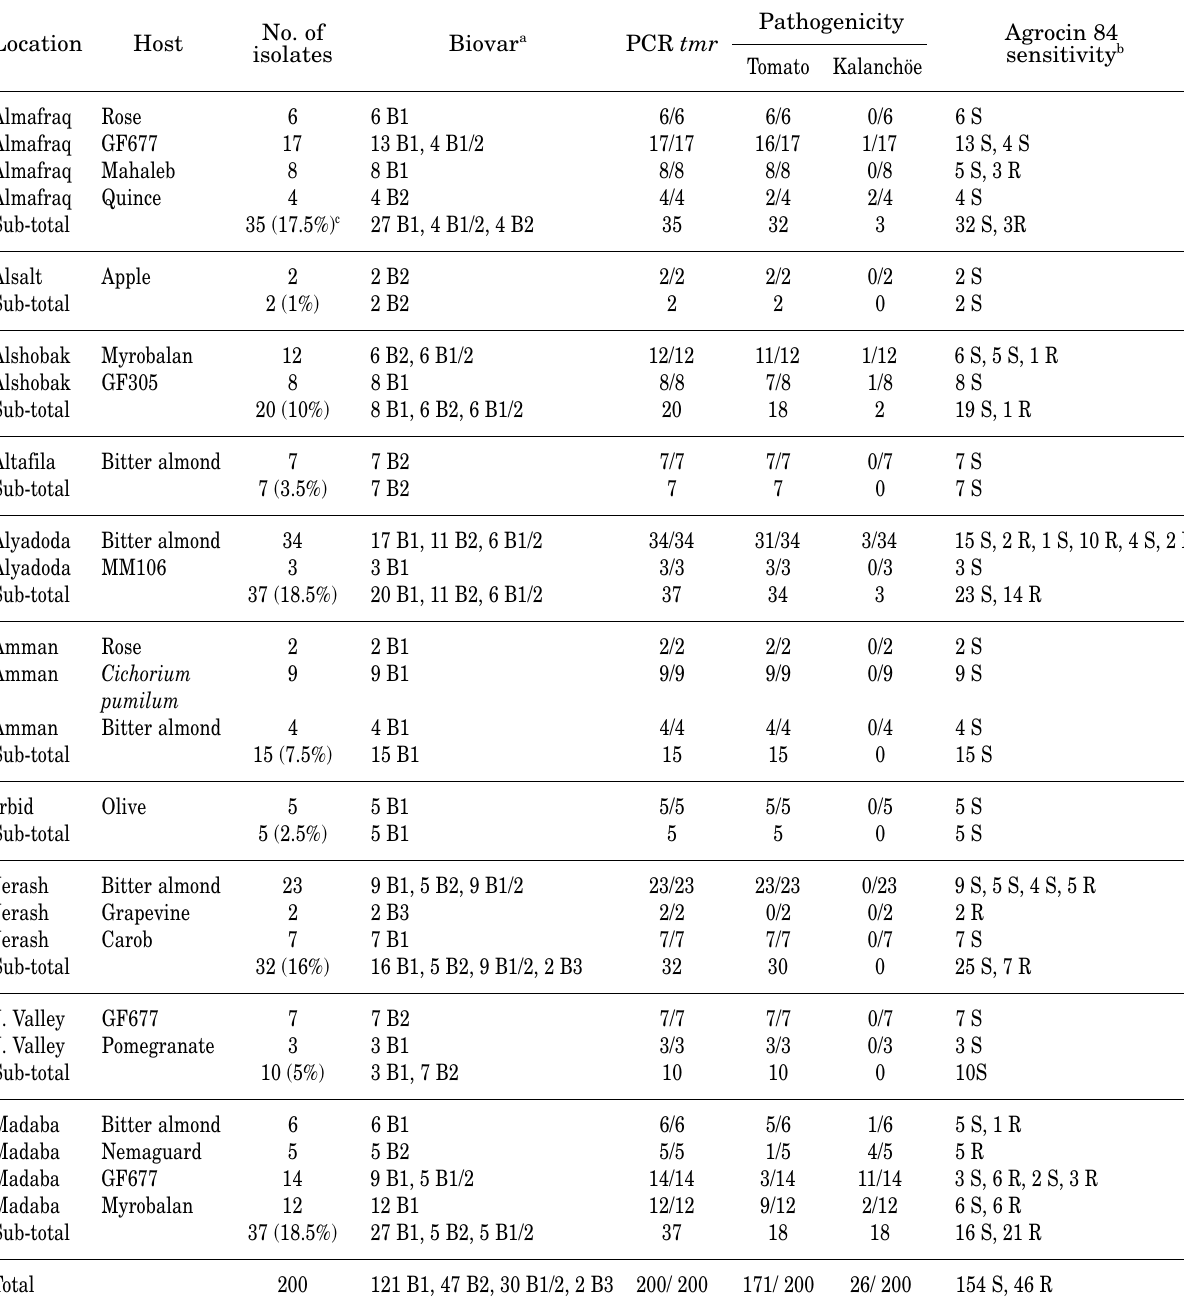
Table 1. Source and results of pathogenicity and agrocin 84 sensitivity tests for Agrobacterium biovars isolated from